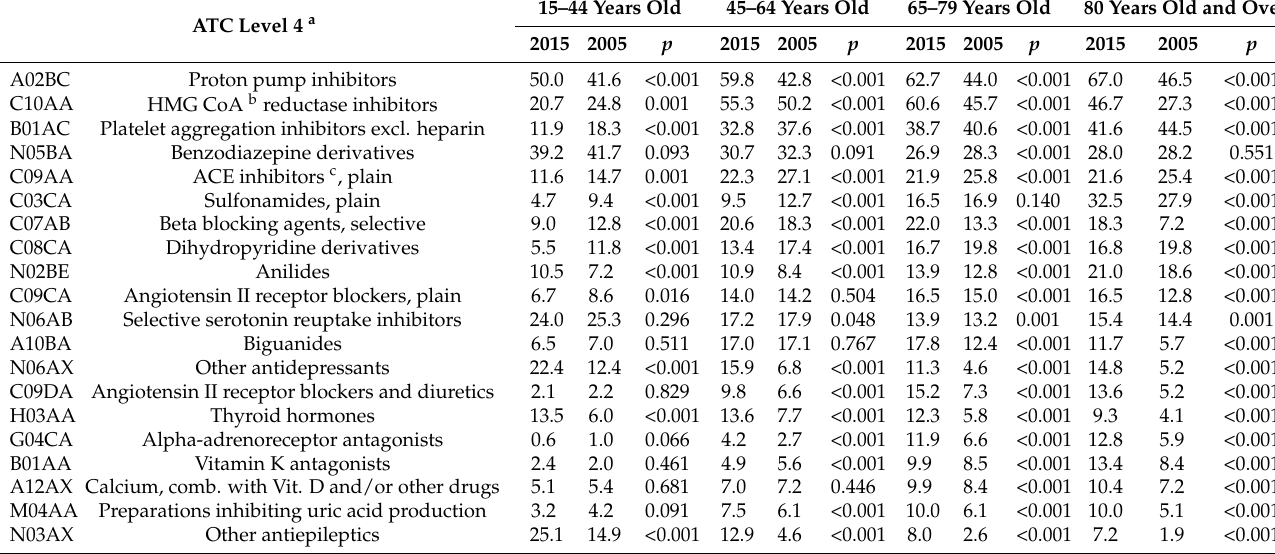
Table 2. Prevalence (%) of the 20 most frequently prescribed courses of treatment (ATC level 4) in patients with polypharmacy in 2015 according to age group and their prevalence in